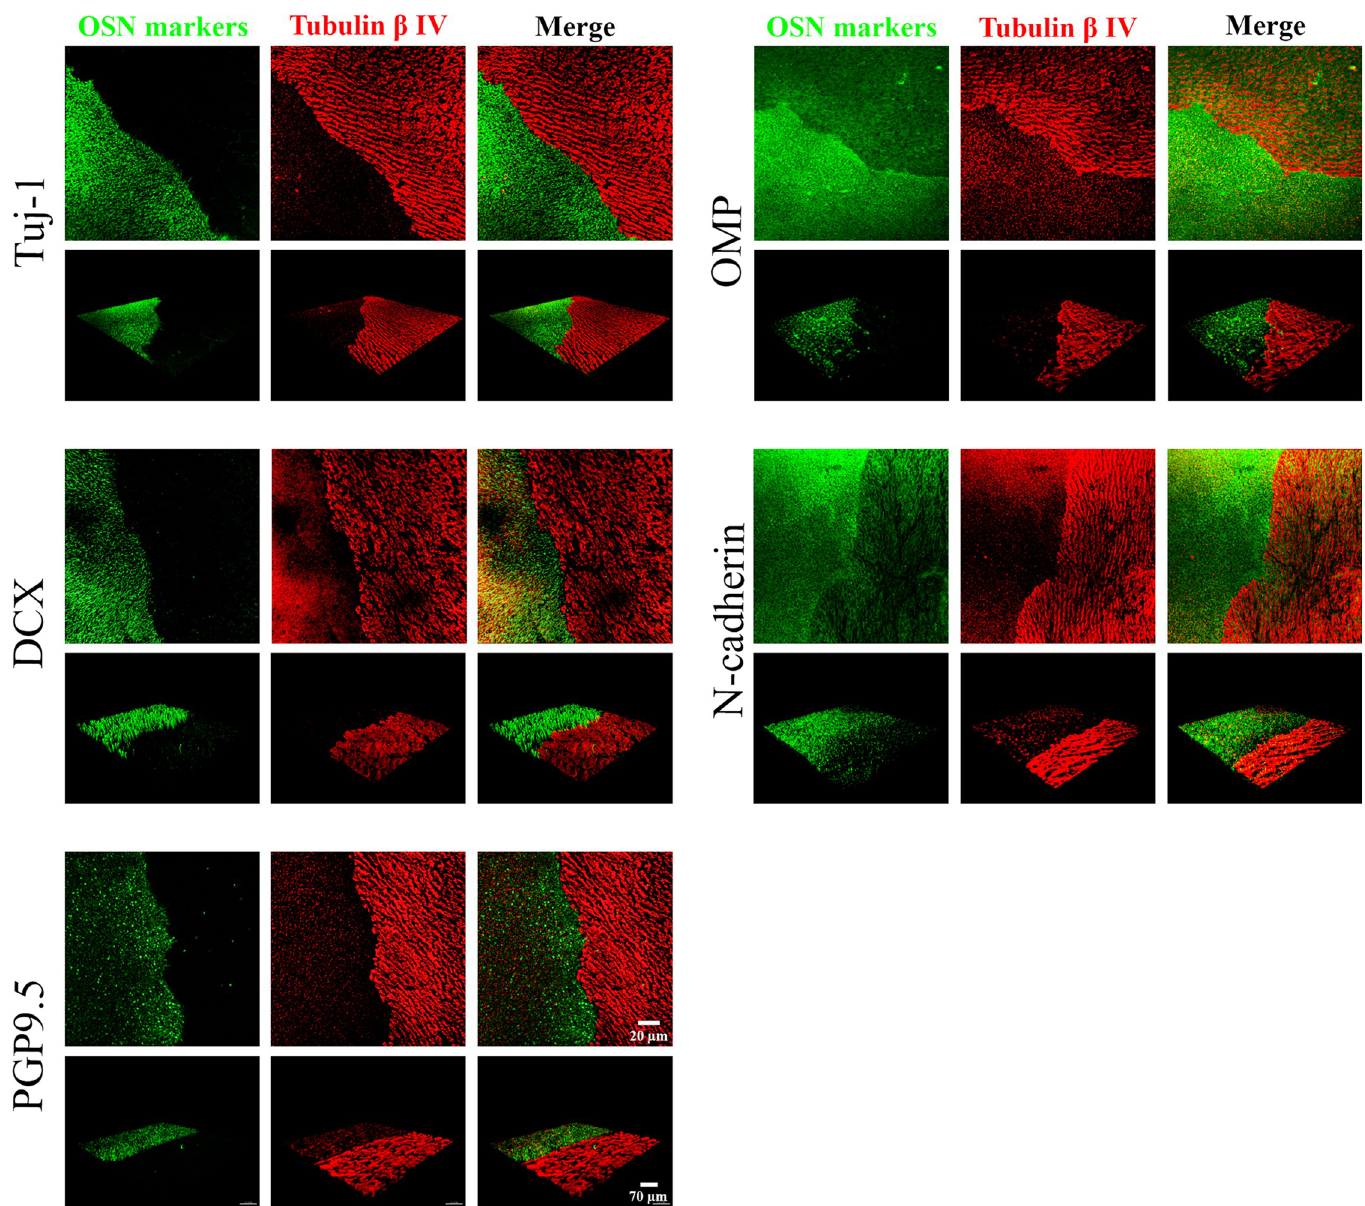
Fig 5. Immunostaining on flat-mounted septal OE using pre-selected OSN markers. Five OSN markers (Tuj-1, OMP, DCX, N-cadherine and PGP9.5) were selected because of their staining of the OE’s surface (OSN dendrites). The co-localization with a respiratory epithelium marker, Tubulin β IV was realized on transition zones in order to show the specificity of the OSN markers. The images were acquired using a confocal microscope and presented as 3D projection. For each marker, the top pictures showed face view using a 20X objective; the bottom pictures showed a tangential view.